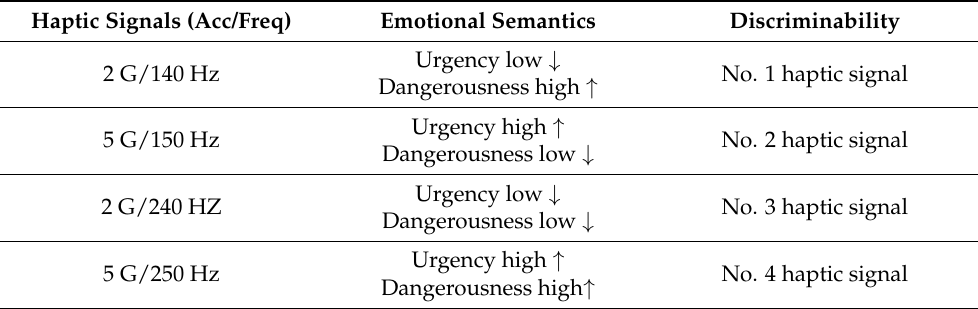
Table 7. Emotional semantic design haptic signals and discriminability haptic signals. Haptic Signals (Acc/Freq) Emotional Semantics Discriminability 2 G/140